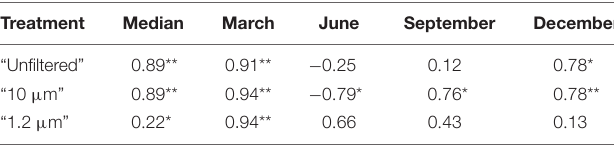
TABLE 4 | Coefficients of the Pearson correlation between chlorophyll a and total particulate carbon (values as medians for the particular experiment/treatment); * and ** indicate